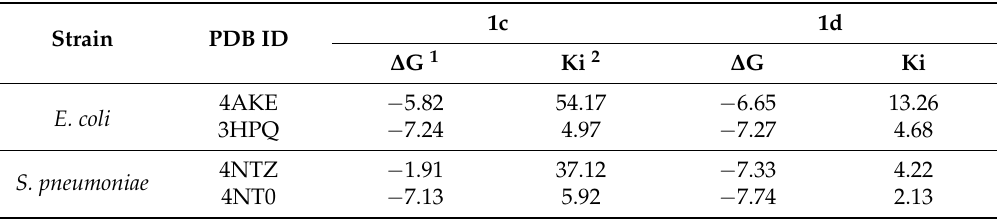
Table 3. Analysis of the inhibitory activity of the derivatives 1c and 1d against open and closed-conformations of E. coli and S. pneumoniae